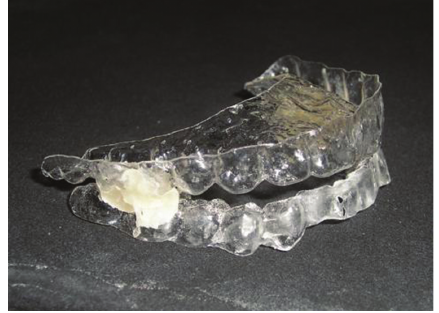
Figure 1: One-piece